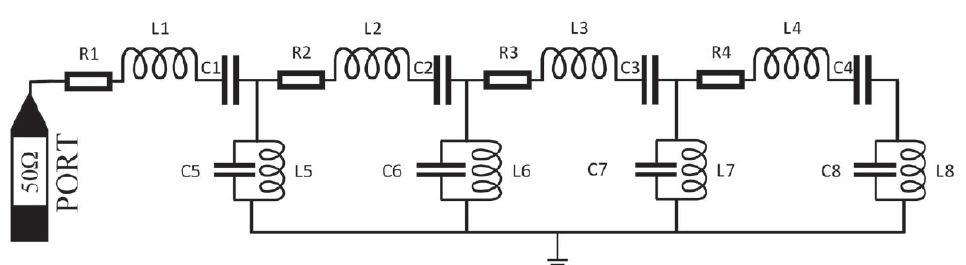
Figure 6. Equivalent lumped element circuit model of the proposed hexagonal microstrip fractal antenna.